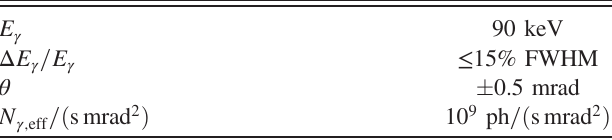
TABLE I. Design parameters for an XFI source